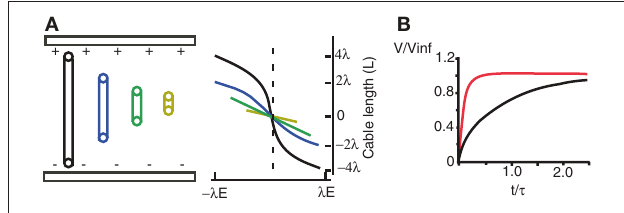
Figure 2 | Spatiotemporal properties of field effects. (A) Cylinders of varying electrotonic length (colors) in a uniform electric field (E). The membrane polarization along the cable depends on the cable’s electrotonic length. Adapted from Chan and Nicholson (1986). (B) Extra- (red) and intracellular (black) stimulation of a passive sphere results in a different time course of membrane polarization. Adapted from Cartee and Plonsey